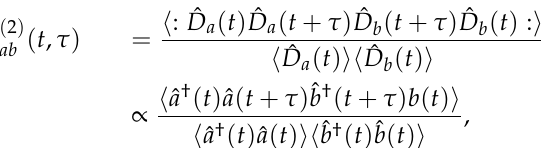
( 2 ) ( t ,0 ) between the two modes with ab